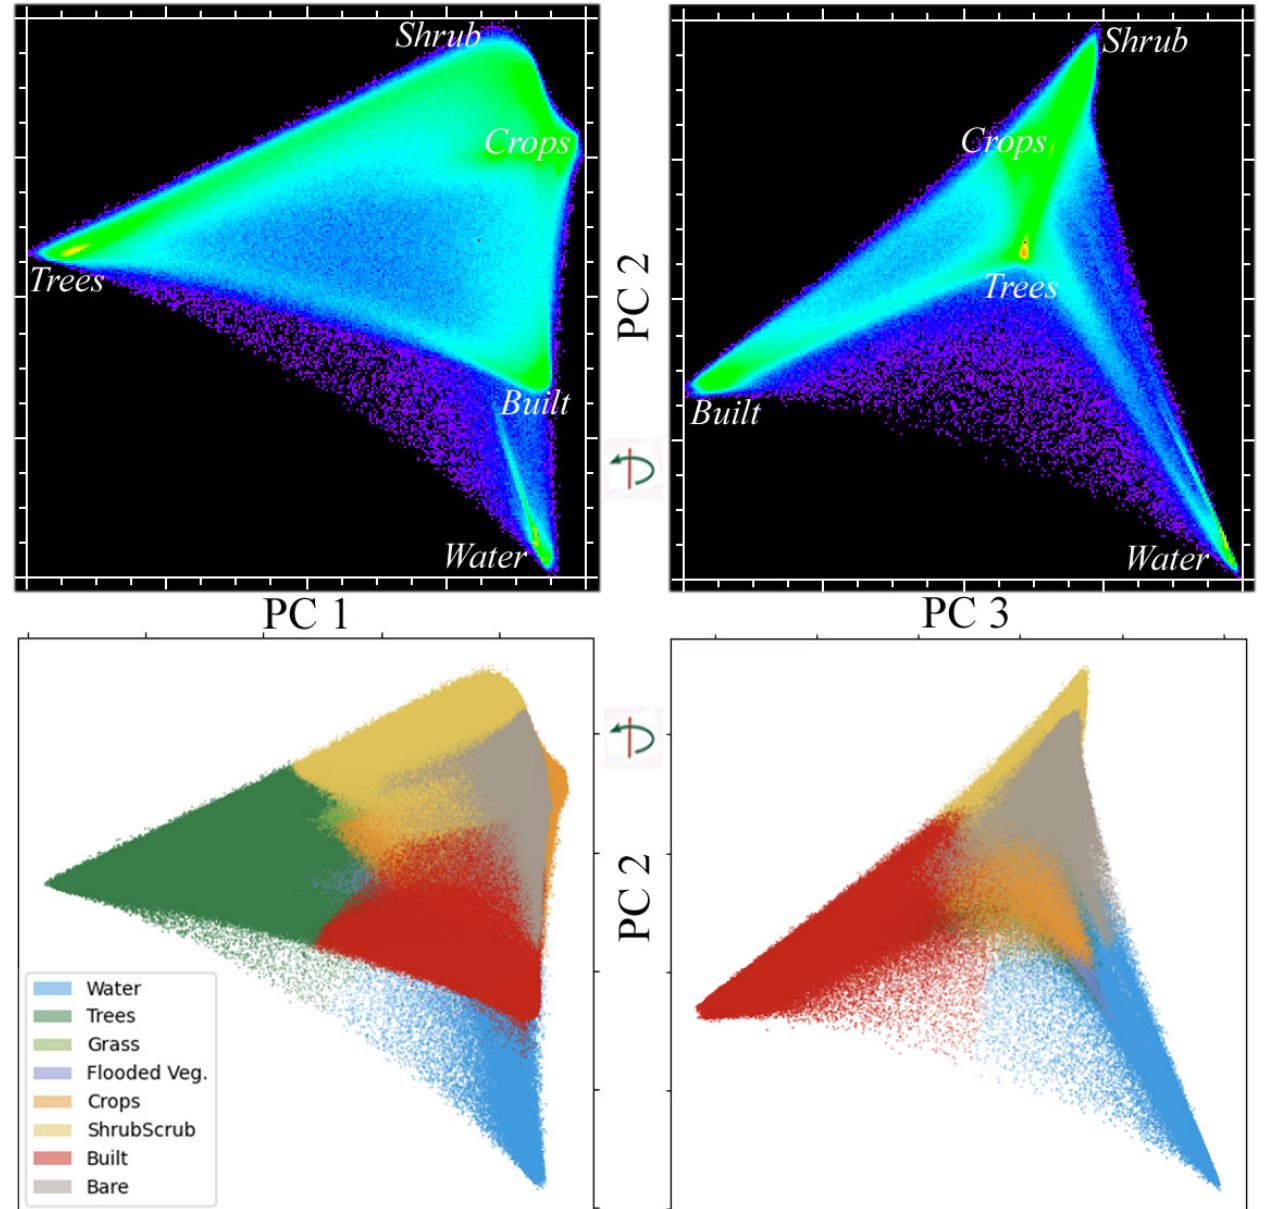
Figure 8. Class probability feature spaces for the nine-site composite. Low-order principal compo- nents form a tetrahedral space with continua spanning Trees, Shrub, Crops, Bare, and Built, while Water is more distinct. Density-shaded distributions (top) illustrate the land cover continuum as distinct from Water, while the maximum probability class distribution shows the decision boundaries at intermediate probabilities. Density-shading uses the same cool to warm color table as Figures 2 and 3. The Tree class was omitted for clarity on PC3–PC2 class projection, lower right.